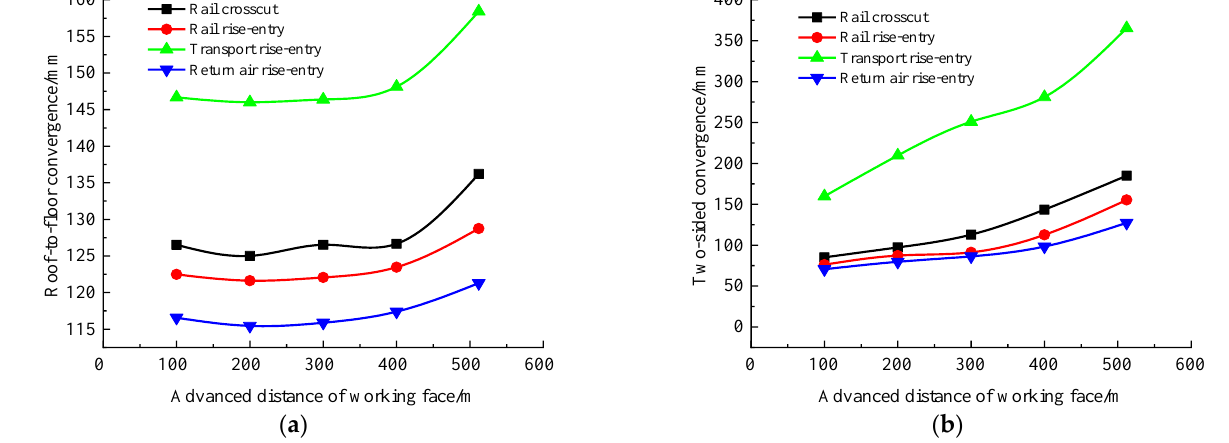
Figure 6. Monitoring results of convergence in roadway-concentrated areas during the advancing process of the No. 360801 coal face. ( a ) Roof-to-floor convergence, ( b ) Two-sided convergence. It can be seen from Figure 6 that with the increase of the advancing distance of the coal face, for the roof-to-floor convergence, each roadway did not change before the ad- vancing distance was less than 300 m. When the advancing distance was greater than 300 m, there was a significant increasing trend, and the two-sided convergence showed a gradually increasing trend from the beginning. In general, when the coal faces advances to 512 m, the − 706-rail crosscut, rail rise-entry, transport rise-entry, and return air rise- entry the roof-to-floor convergence increased by 7.66%, 5.11%, 8%, and 4.06%, respec- tively, compared with 100 m. The two-sided convergence increased by 117.32%, 103.8%, 128.6%, and 59.65%, respectively. Combined with the two above sets of data, it can be seen that with the increase of the advancing distance of the coal face, the influence on the two- sided convergence was greater than that of the roof-to-floor convergence, but the basic trend remained unchanged.